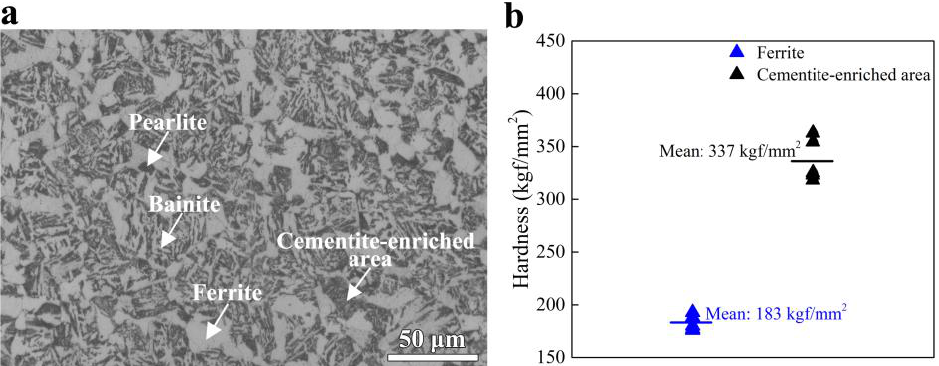
Figure 6. Microstructure characteristics of 25CrMo4 steel. ( a ) Microstructure image and ( b ) hardness of ferrite and cementite-enriched area in the microstructure.